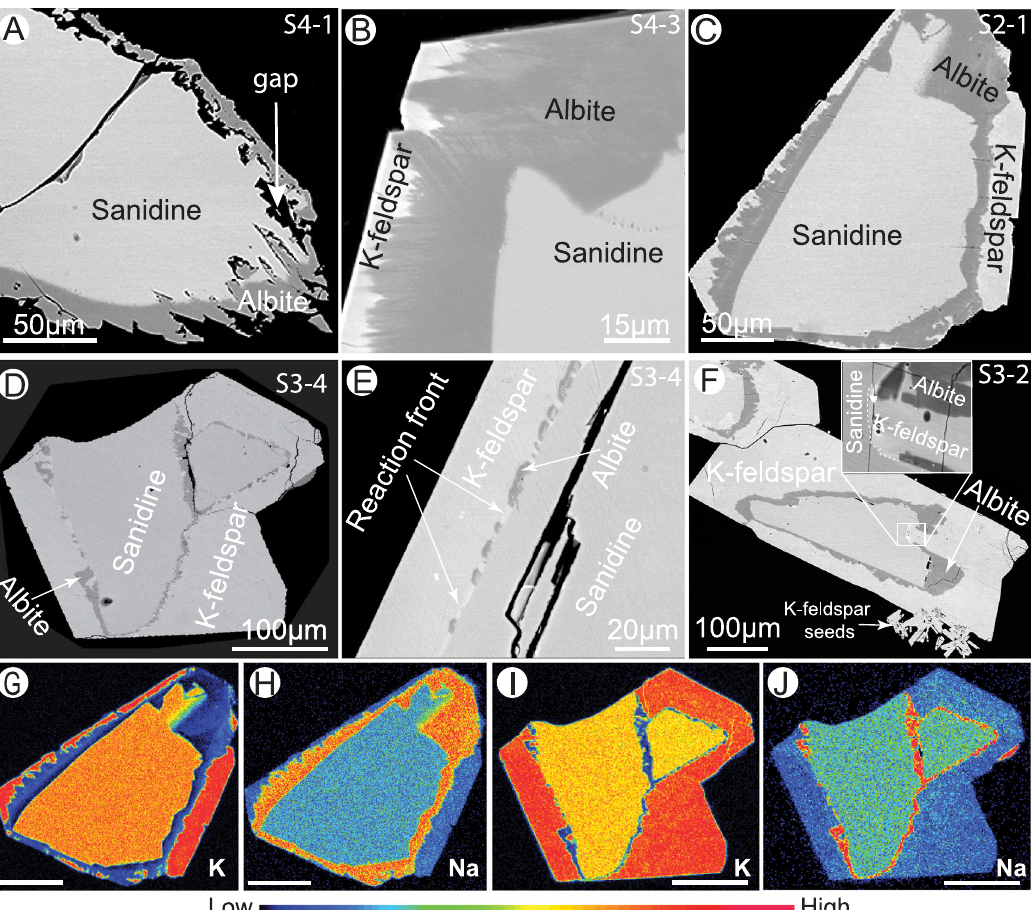
Fig. 2 Reaction products and textures as a function of reaction time in NaCl- and NaF-solutions. BSE images of reaction products from NaCl solution for 1 ( A ), 3 ( B ) and 5 days ( C ), and NaF solution for 1 ( D , E ) and 5 days ( F ). EMPA chemical maps of grains shown in C [ G , H ] and D [ I , J ]. Scale bars in G – J are 100 µ m. The colour bar represents the contents of K or